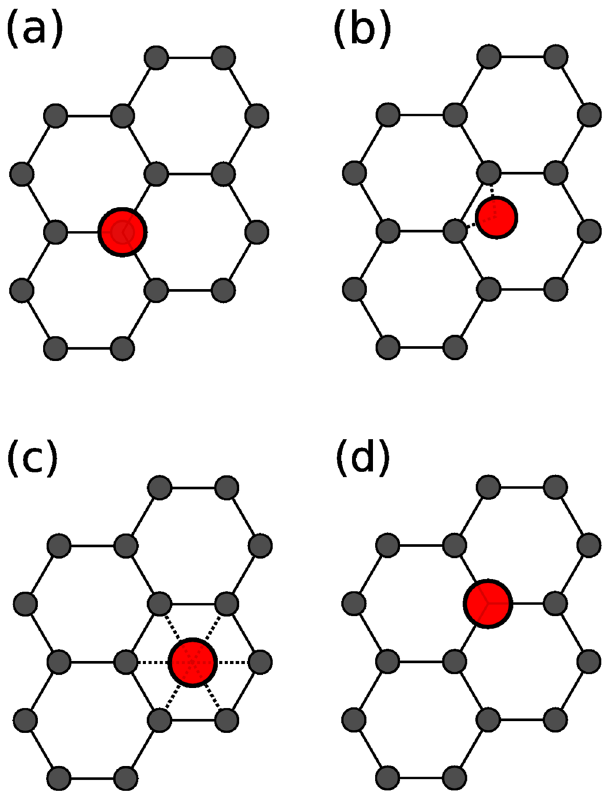
Figure 1. Illustration of the high symmetry adsorption sites. Neutral atoms and charged ions of heavy metals are placed at the ( a ) on-top ( T ), ( b ) bridge ( B ), and ( c ) hollow ( H ) sites on the hexagonal cell, as well as, on a defect ( D ) site ( d ) of graphene sheet (substitutional